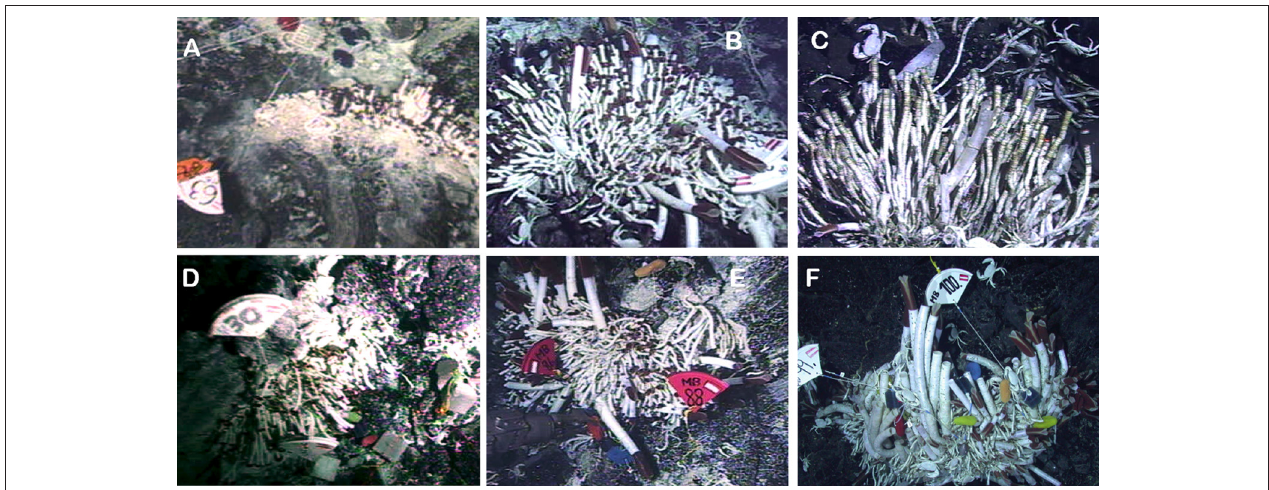
FIGURE 3 | Succession of vent communities after the volcanic eruption at the 9 ◦ 50 ′ N East Pacific Rise in 2006. (A–C) at P-Vent: Small patches of tubeworms Tevnia jerichonana ∼ 1 year posteruption (A) changed into a mixed T. jerichonana and Riftia pachyptila community 2 years posteruption (B) , to mostly dead tubeworms due to ceased vent fluids 4 years posteruption (C) . (D–F) at Tica site: Patches of T. jerichonana 1 year posteruption (D) sequentially changed into a mixed T. jerichonana and R. pachyptila community ∼ 2 years posteruption (E) , and to a mixed R. pachyptila and T. jerichonana community 4 years posteruption (F) . Permission to re-use material from Klose et al.